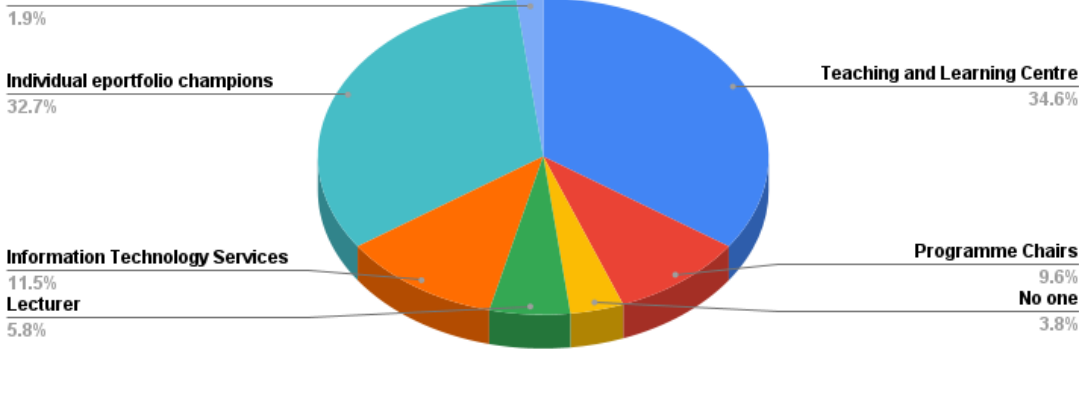
Figure 3. Leadership of eportfolio implementation